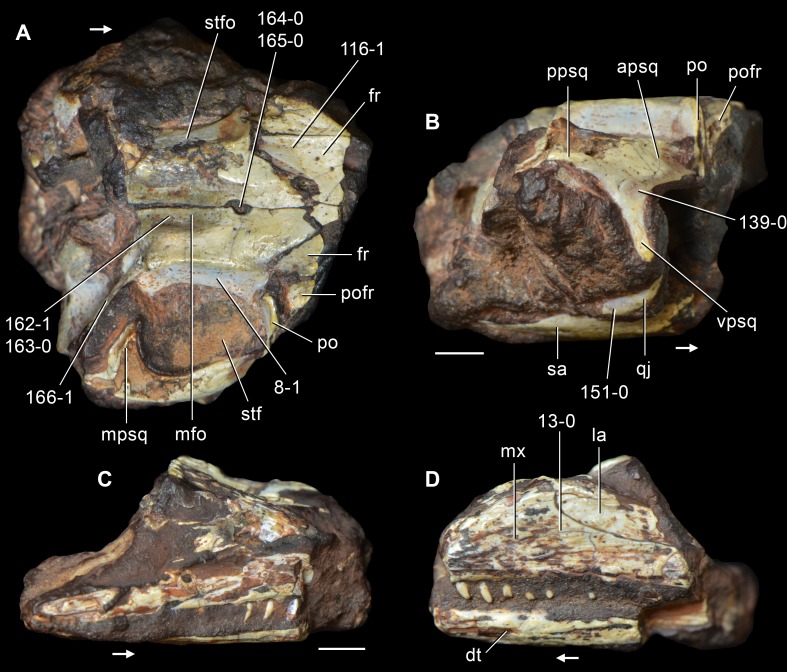
Kadimakara australiensis.(A, B) Holotype postorbital region of skull (QMF 6710) and (C, D) referred snout (QMF 6676) in (A) dorsal; (B, C) right lateral; (D) and left lateral views. Numbers indicate character-states scored in the data matrix and the arrows indicate anterior direction. Abbreviations: apsq, anterior process of the squamosal; dt, dentary; fr, frontal; la, lacrimal; mfo, median fossa; mpsq, medial process of the squamosal; mx, maxilla; po, postorbital; pofr, postfrontal; ppsq, posterior process of the squamosal; qj, quadratojugal; sa, surangular; stf, supratemporal fenestra; stfo, supratemporal fossa; vpsq, ventral process of the squamosal. Scale bars equal 2 mm.